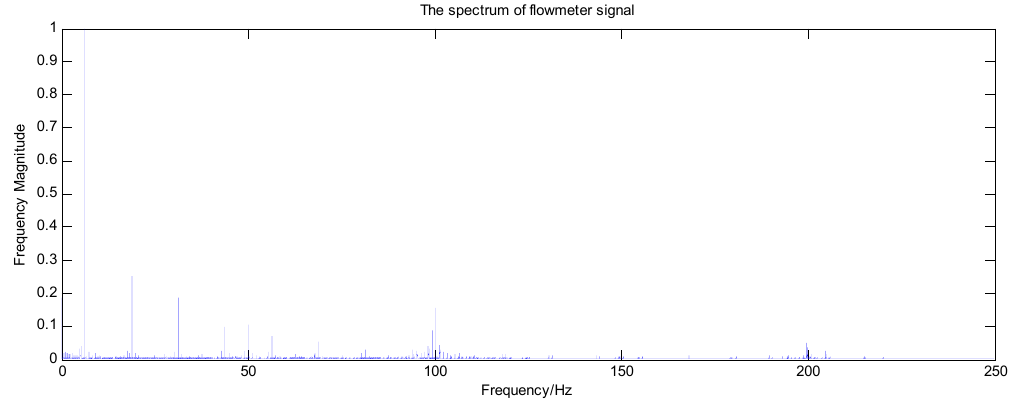
Figure 4. The spectrum of the original signal.